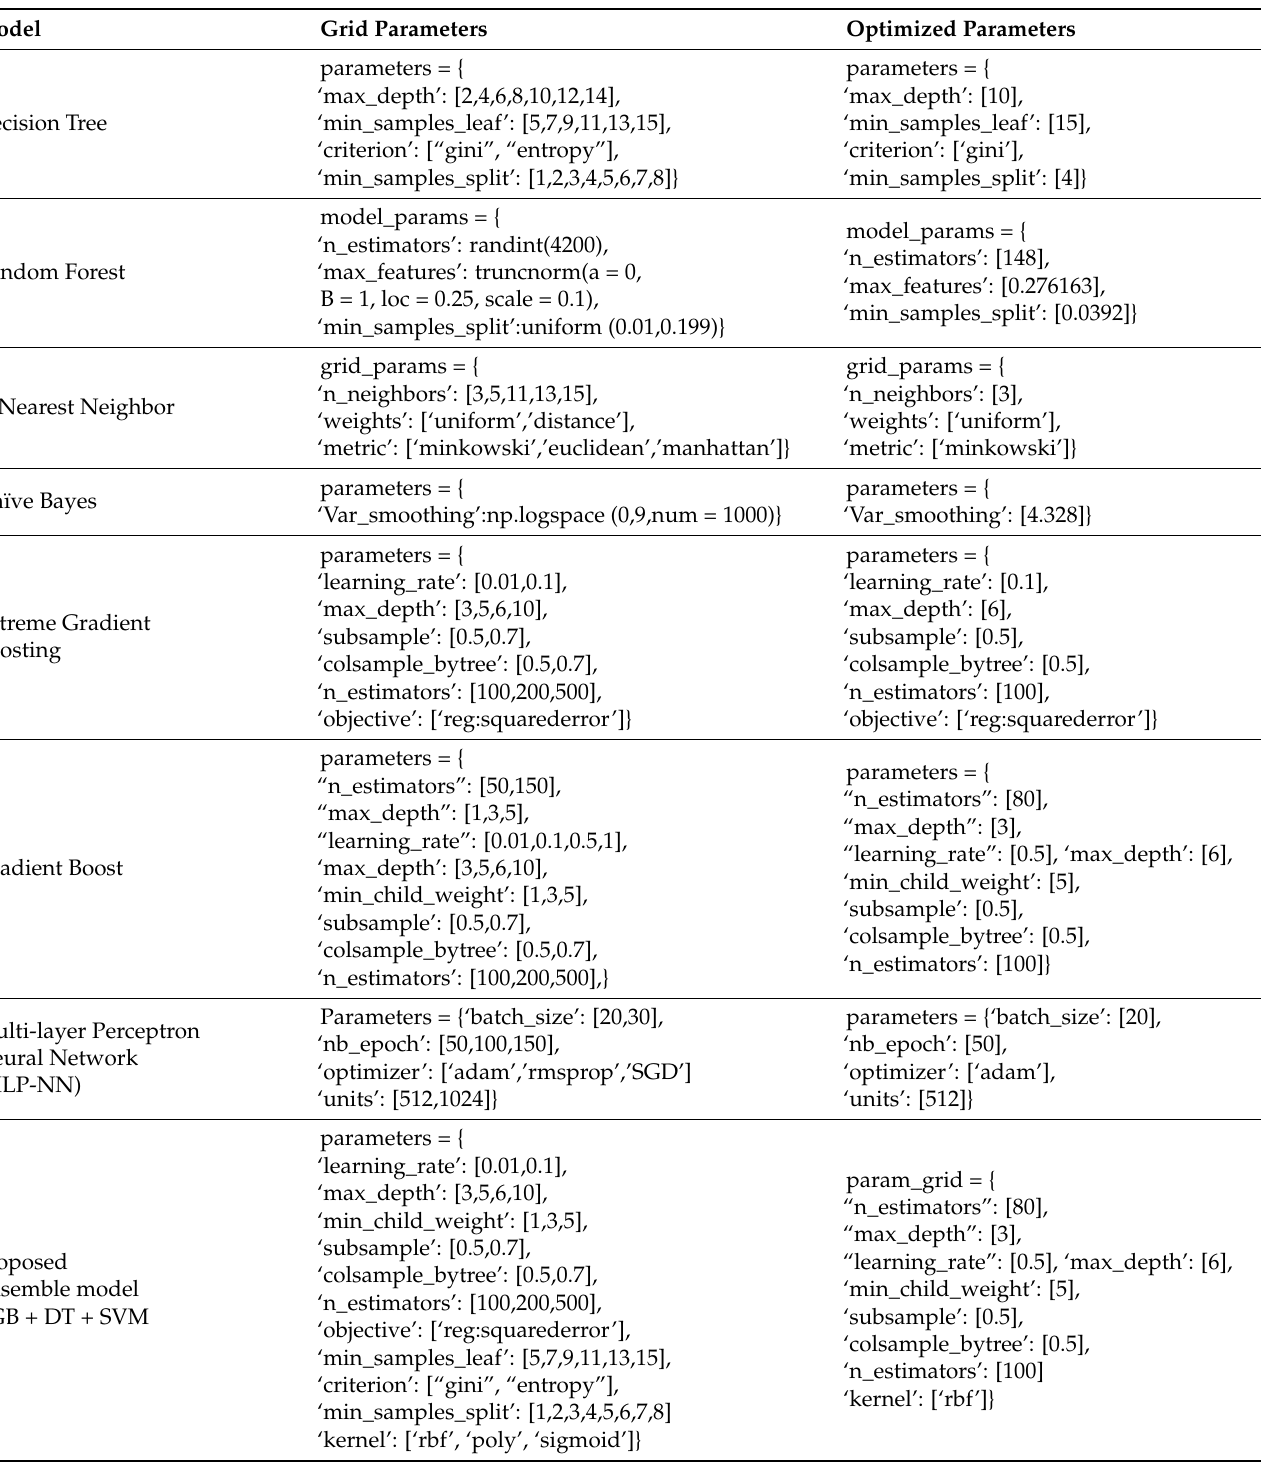
Table 4. Hyperparameter tuning to obtain optimized parameters using